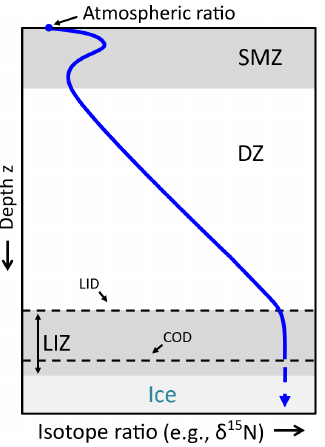
Figure 2. Schematic depiction of a typical isotope profile. The sur- face mixed zone (SMZ), the diffusive zone (DZ), the lock-in zone (LIZ), and the ice below are indicated by shading. Further indicated are the lock-in depth (LID) and the close-off depth (COD) (see text). (cid:49)m the isotope mass difference (kg mol − 1 ), g the